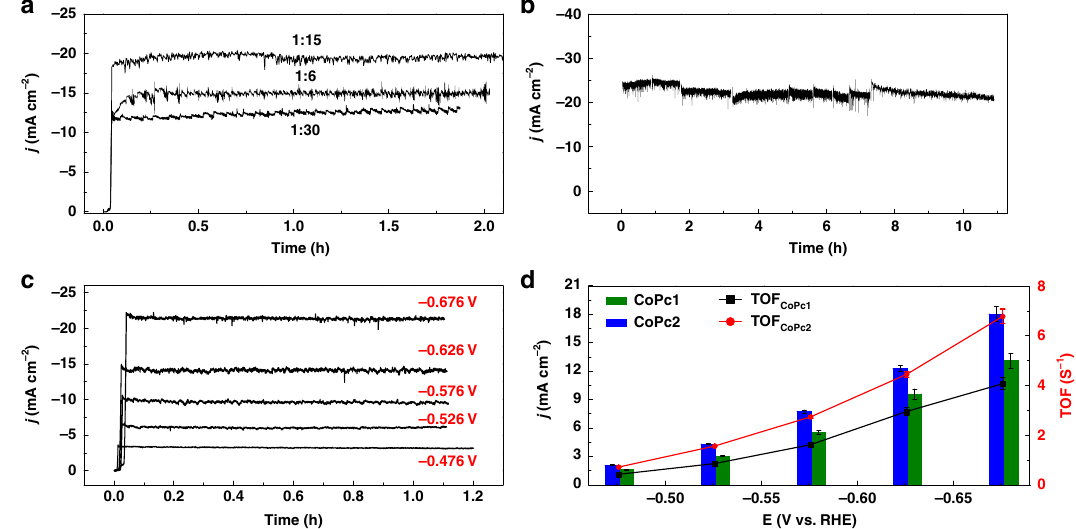
Fig. 3 Controlled potential electrolysis of CO 2 reduction. a Electrolysis current densities ( E = − 0.676 V vs. RHE) for a CoPc2 @MWCNTs fi lm at various catalyst mass ratio. b Long-term electrolysis ( E = − 0.676 V vs. RHE) at optimized mass ratio. c Variation of the current as a function of the electrolysis potential at optimized mass ratio (see text). d Current density and rate constant (TOF) for CoPc1 @MWCNTs and CoPc2 @MWCNTs for CO production in a CO 2 saturated solution containing 0.5 M NaHCO 3 (pH 7.3). The uncertainties represent standard errors obtained from four measurements Electrolysis experiments at neutral and acidic pH . After the The CO selectivity was typically 92 – 93% in repeated runs, catalytic ink was deposited on a carbon paper electrode (see with H 2 being identi fi ed as a minor gas phase by-product (7 – 8%). No other product was detected in the liquid phase Methods and Supplementary Fig. 3 for a scanning electron upon nuclear magnetic resonance (NMR) analysis. The microscopy (SEM) image of the porous catalytic fi lm), bulk electrolysis performed in the absence of catalyst or with electrolysis was performed at pH neutral conditions with CoPc2 CoPc2 @MWCNTs (1:15) under Ar atmosphere only furnished for various loadings of the molecular catalyst. An optimal loading H 2 (Supplementary Fig. 4). The TON and TOF values in ratio of 1:15 (catalyst:MWCNTs weight ratio) shows reasonably Tables 1 and 2 and in the text were calculated using the total good stability over the course of the 2 h experiments (Fig. 3a). NATURE COMMUNICATIONS| (2019) 10:3602